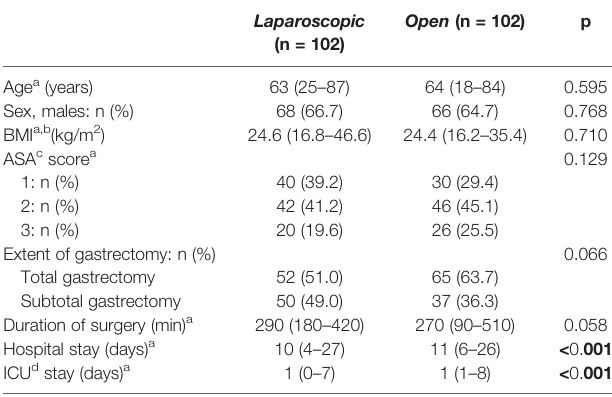
TABLE 1 | Patient characteristics, perioperative data, and surgical